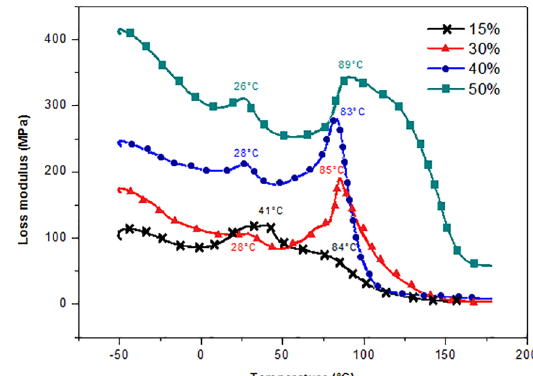
Figure 4. Variation of the storage modulus, E', with the temperature for the fique fabric composites. Table 1. Storage modulus temperature-related parameters for epoxy composites reinforced with fique fabric Epoxy composite reinforced fique fabric (vol%)